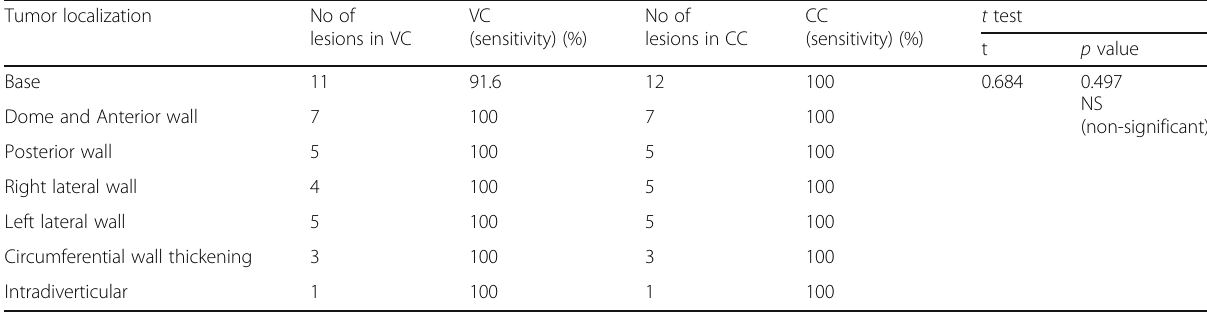
Table 10 Comparison between conventional cystoscopy (CC) and virtual cystoscopy (VC) and their sensitivity regarding the tumor localization Tumor